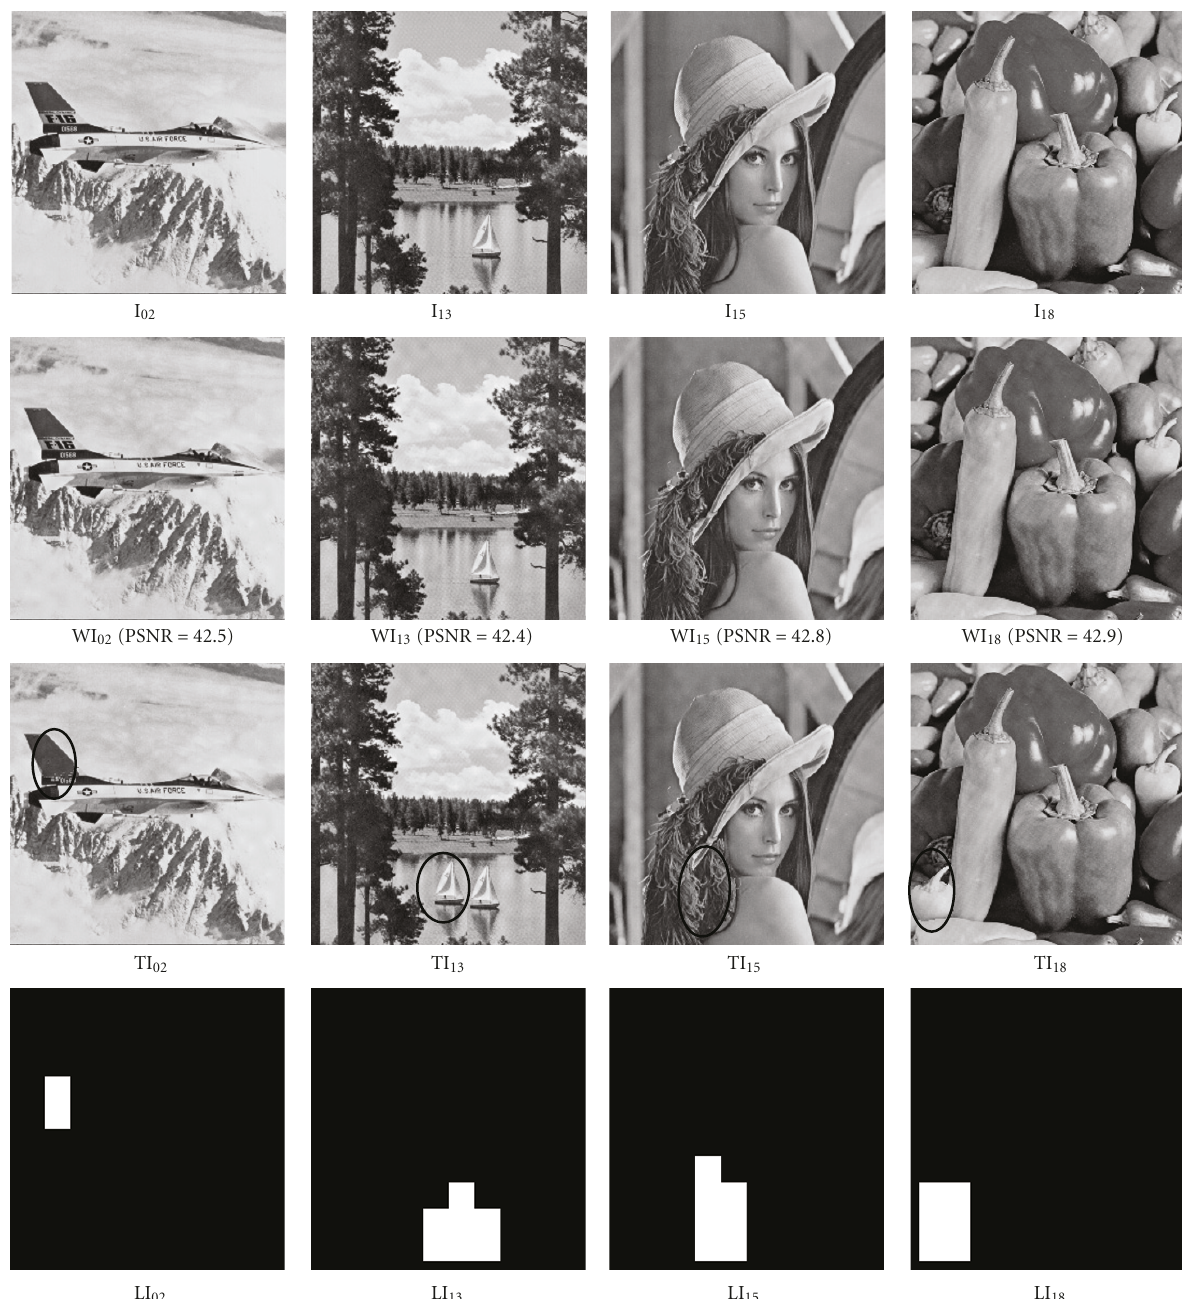
Figure 11: Authentication results when some standard test images are maliciously manipulated where I: original standard image, WI: watermarked image, TI: tampered watermarked image and the oval highlights the tampered part, LI: location of the attacked areas.